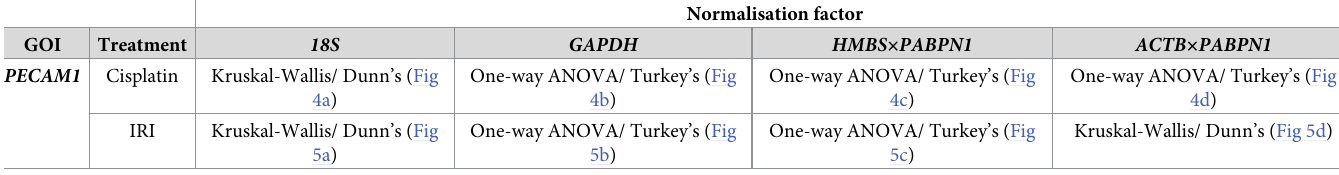
Table 9. Statistical methods used to analyse PECAM1 gene